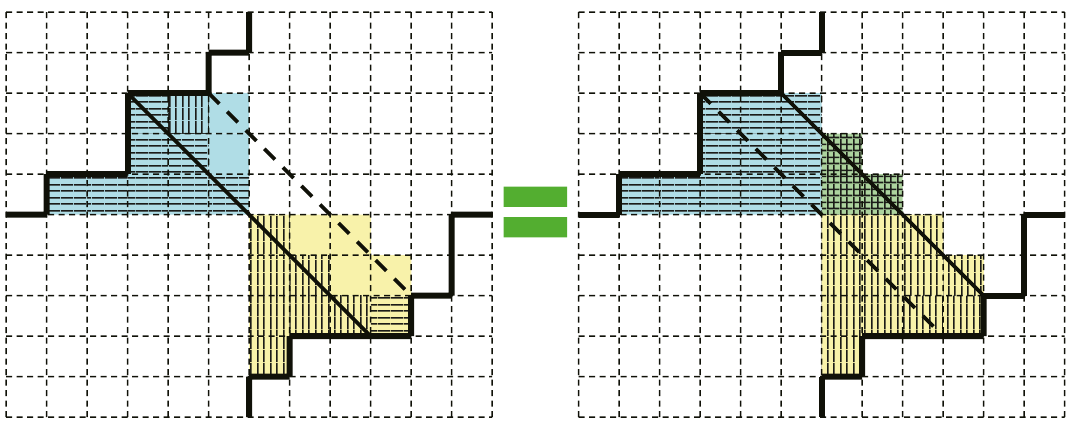
Figure 3 . A pictorial interpretation of the computation of the signs in (3.13). Each term can be interpreted as the area in the composite Young diagram. On the left-hand side of (3.13), P r ( (cid:12) j + 1), P r (cid:11) i , MR , P r (cid:11) i , (cid:0) MR and P r ( (cid:12) + 1) are respectively regarded as i j =1 i =1 i = R +1 i = R +1 the numbers of yellow boxes with vertical strips, cyan boxes with horizontal strips, yellow boxes without strips, yellow boxes with horizontal strips, cyan boxes without strips and cyan boxes with vertical strips. On the right-hand side, P M + R ( B i + 1) and P R + M A i are respectively the total i =1 i =1 number of both yellow boxes and green boxes and that of both cyan boxes and green boxes. Here the contributions from the green boxes cancel each other.